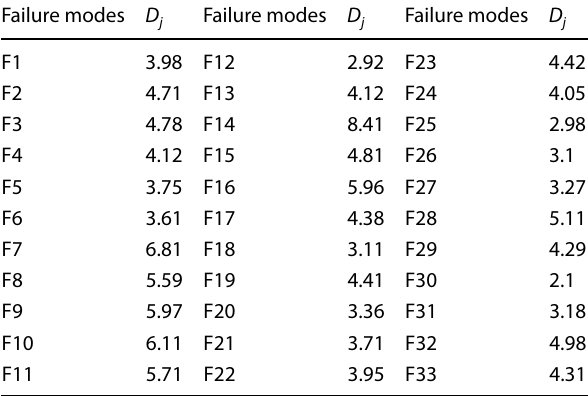
Table 4 Detection numbers of failure